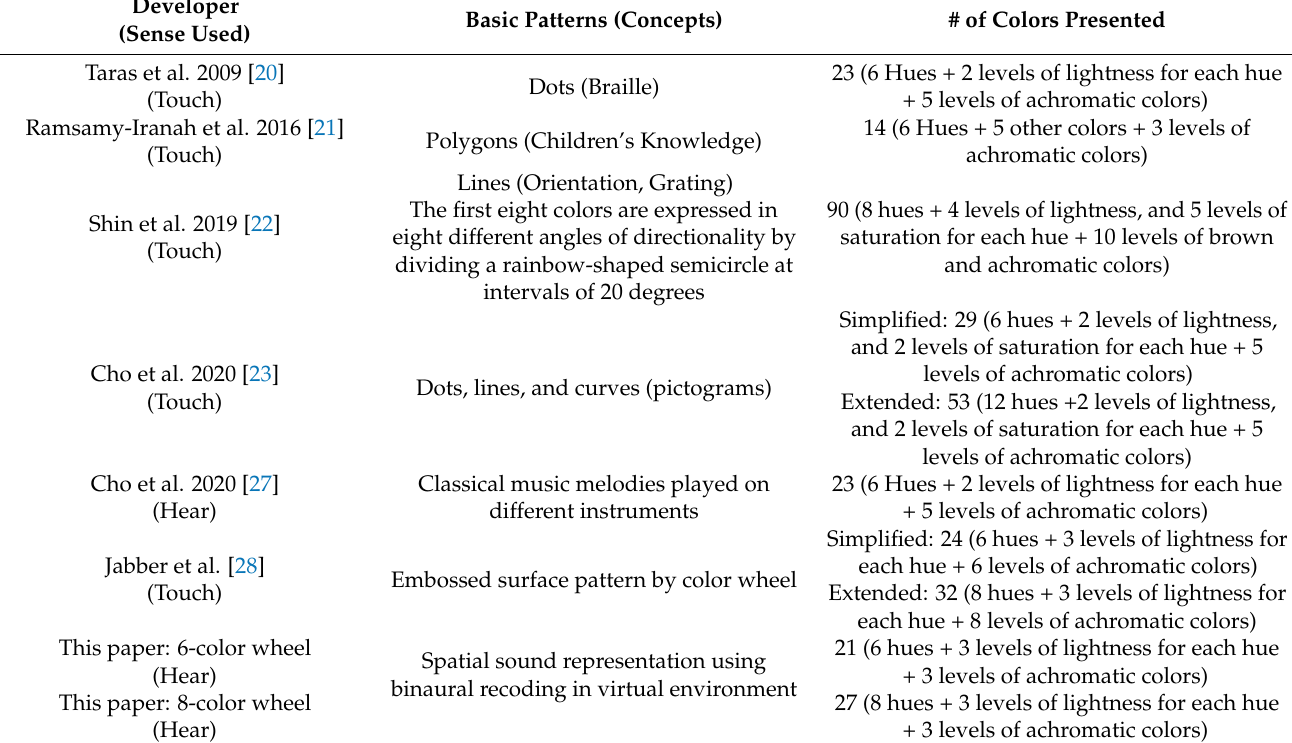
Table 1. Existing color codes with instruments and the color codes in this